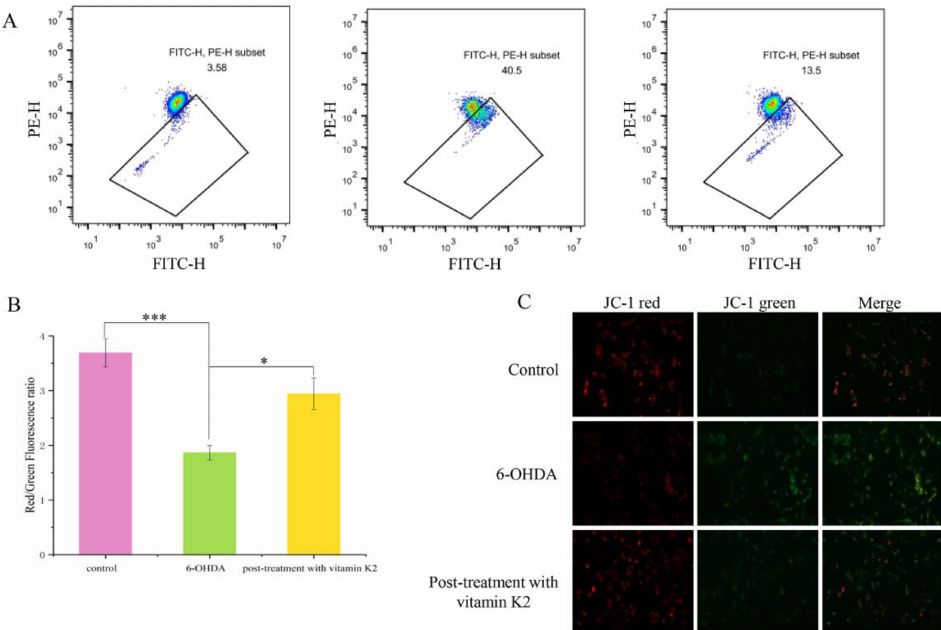
Figure 4. Measurement of the mitochondrial membrane depolarization state by using the JC-1 assay in SH-SY5Y cells. ( A ) Mitochondrial membrane potential in cells were detected by flow cytometry. ( B ) The red/green fluorescence ratio corresponding to the respective fluorescence images. ( C ) Images of cells were taken by fluorescence microscopy. All images were taken with a 20 × objective. Images were taken in red and green modes, where green staining represents JC-1 monomers and red staining represents JC-1 aggregates. The data are presented as mean ± SD ( n = 3). Significant difference * p < 0.5, and *** p < 0.01 vs. control.